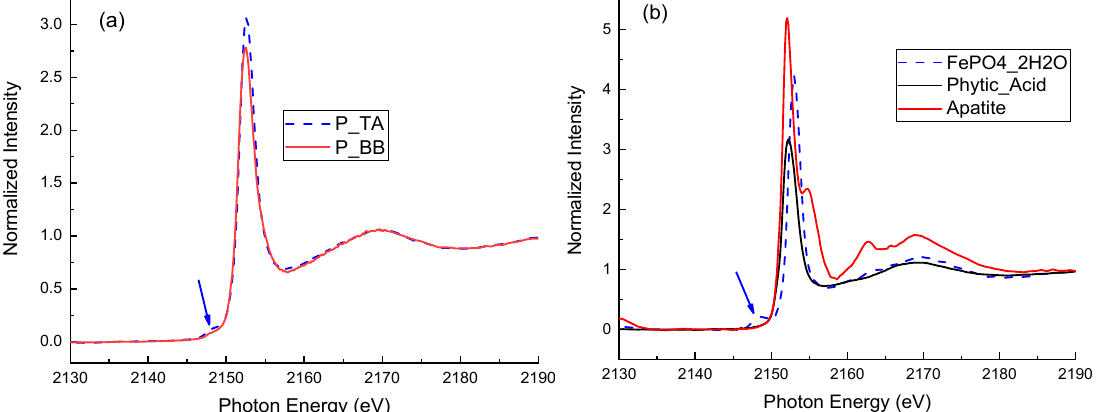
Figure 5. P K-edge XANES spectra of ( a ) bulk TA and BB sediments and ( b ) reference compounds.